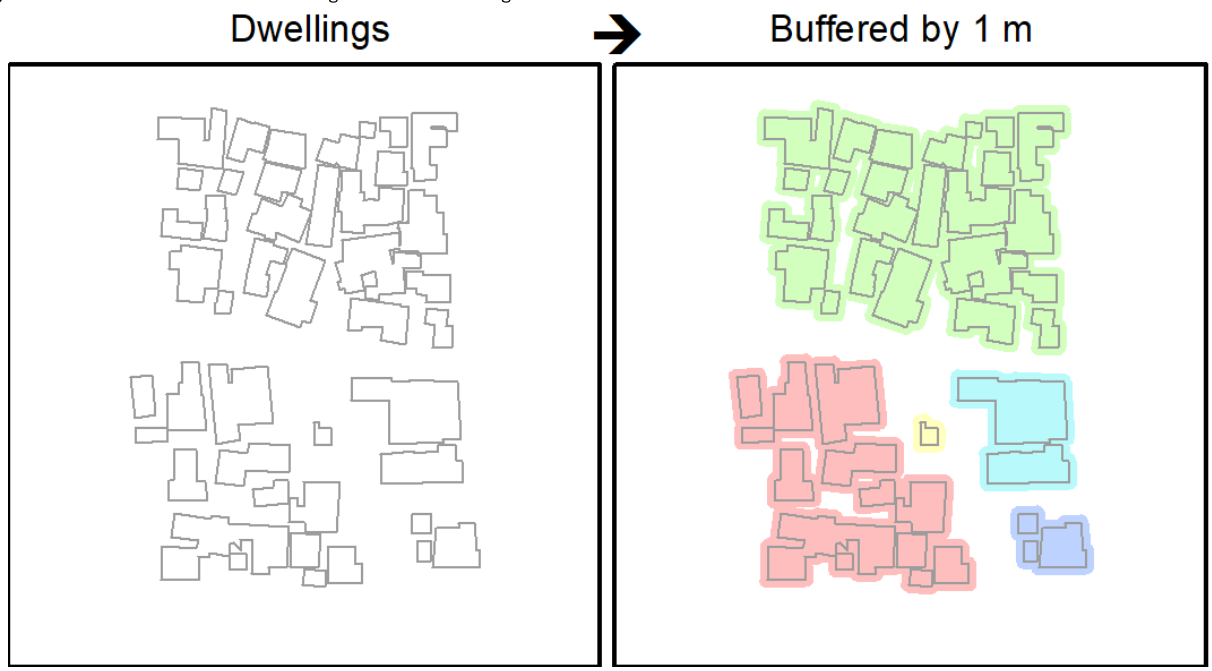
Figure 2. Illustration of how self-isolating clusters of dwellings are identified.